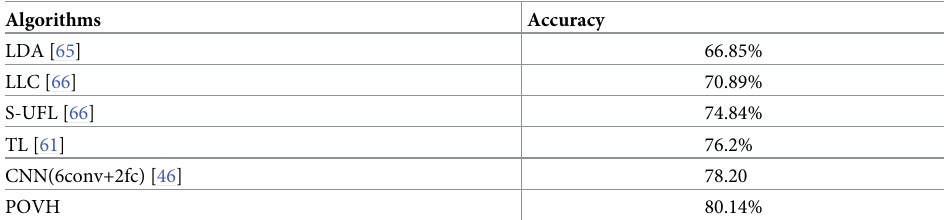
Table 2. Comparison of classification accuracy while using SIRI-WHU